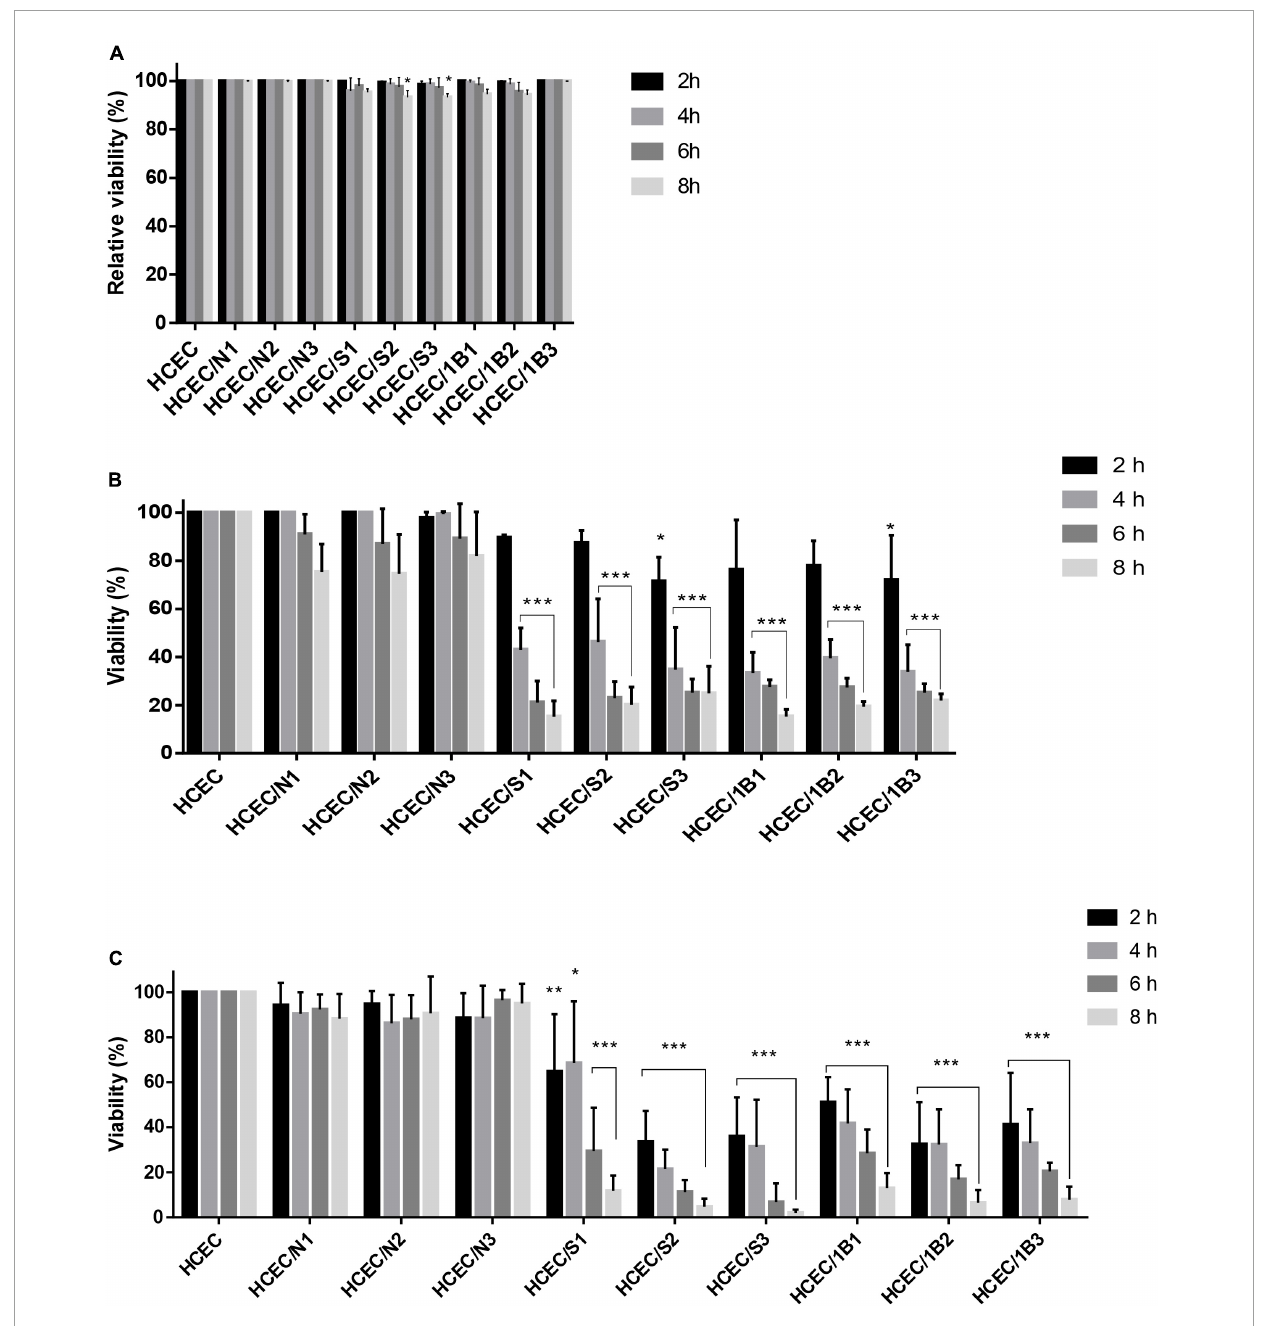
FIGURE5 LDH release (A) , MTS (B) and NanoLuc R (cid:13) Luciferase prosubstrate assays (C) . Percentage of the viability of HCEC alone and after co-culture with Acanthamoeba strains Neff A (N), SIN20 (S) and 1BU (B) for different time periods (2, 4, 6, and 8 h), and MOIs (MOI 1: N1, S1, and B1; MOI 2: N2, S2, and B2; MOI 3: N3, S3, and B3). Values represent the means of three independent experiments, each in triplicate. Data were plotted after the correction of the media background. Statistical analysis was performed through two-way ANOVA with Dunnett’s multiple comparisons test (* P < 0.01, ** P < 0.001, and *** P <